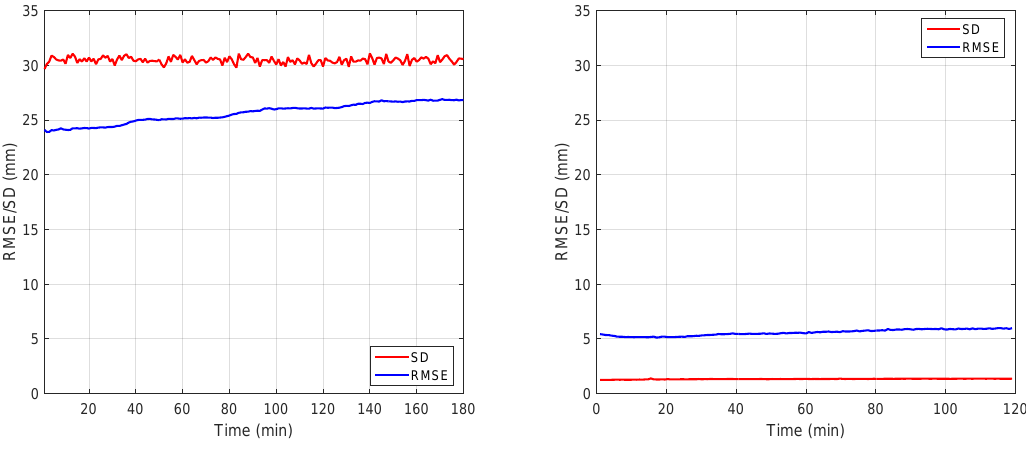
Figure 5. Temperature drift: The Hamamatsu PB-ToF (left) and the Kinect ToF camera